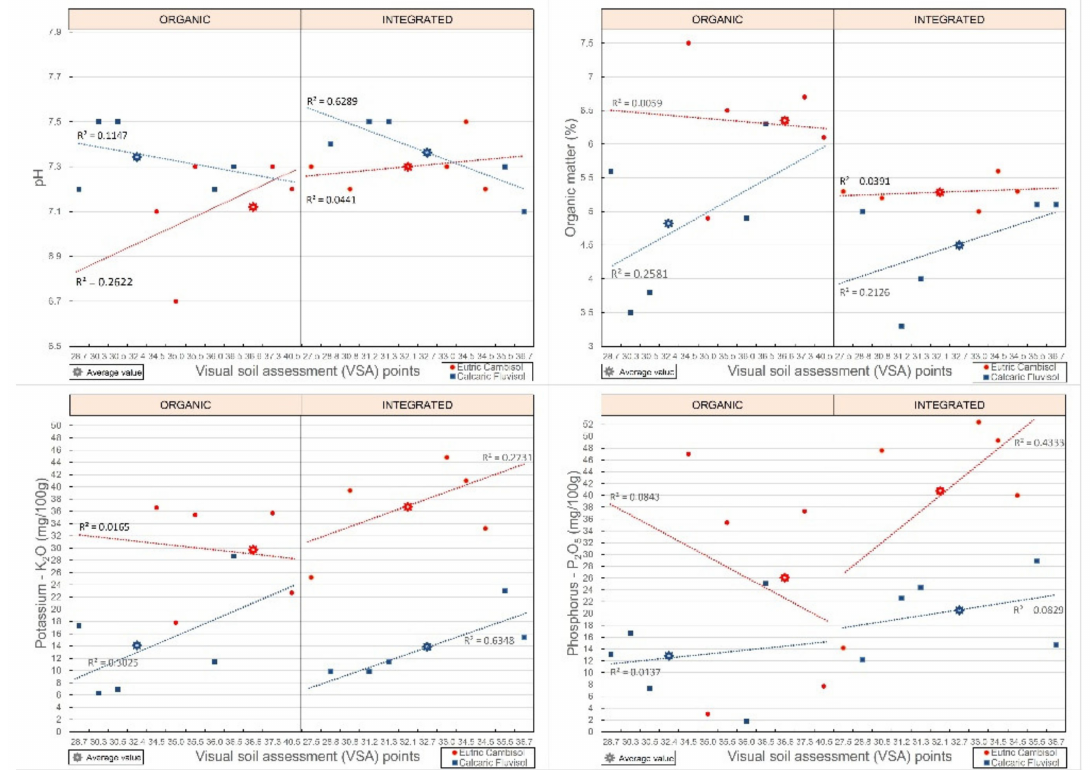
Figure 4. Relationship between the measured soil pH, soil organic matter (%), potassium (K 2 O), phosphorus (P 2 O 5 ), and VSA points of sampled fields in terms of the agricultural management practice type and soil